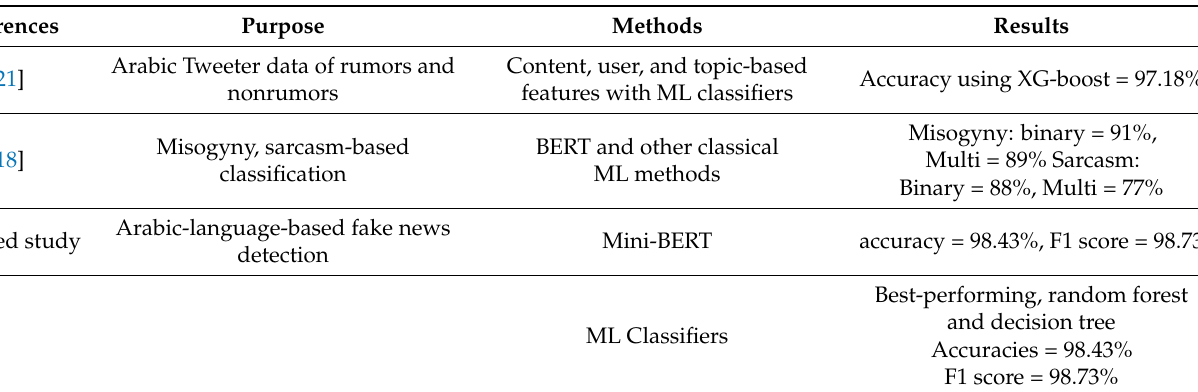
Table 7. Comparison of fake news data using various machine learning and DL